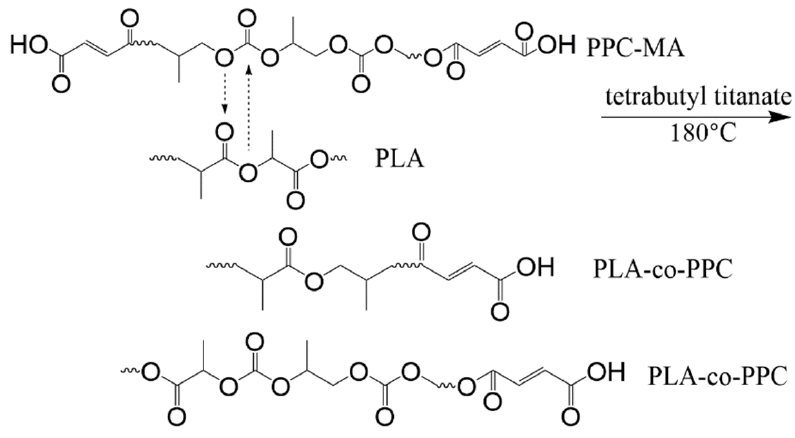
Figure 2. Transesterification reaction of PLA and PPC.